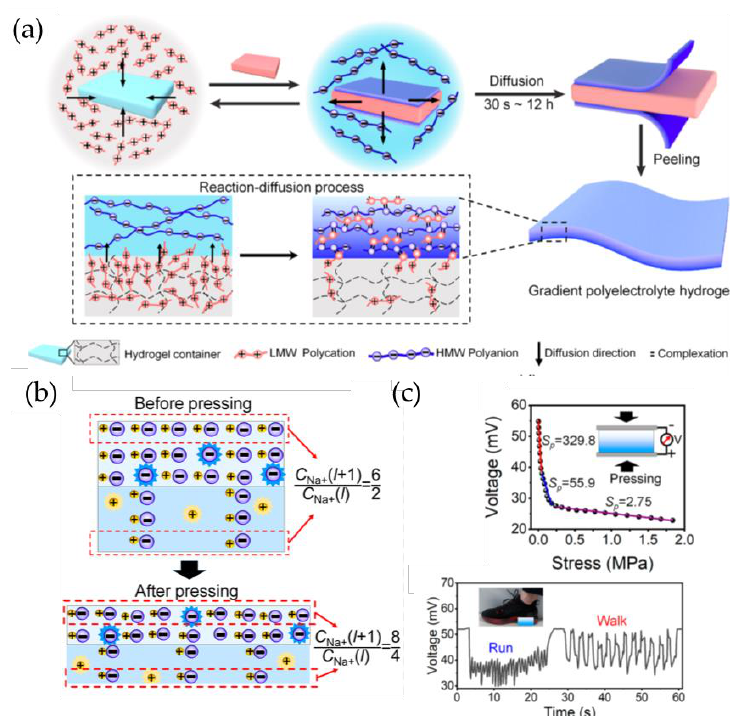
Figure 12. ( a ) Synthesis mechanism of hydrogel-based GPMs. ( b ) Schematic illustration of pressure- sensing mechanism. ( c ) The voltage produced by self-powered i-skins while experiencing gradually increasing pressure, as well as in response to walking and running motions. (Reprinted with per- mission from [84] .)